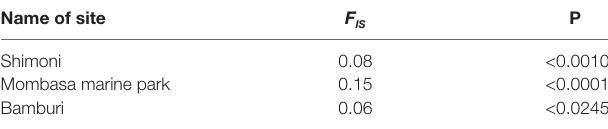
TABLE 4 | Table of specific F IS indices in each site revealing significant levels of inbreeding of Lethrinus mahsena population collected from Mombasa Marine Park, Bamburi, and Shimoni, coastal Kenya, as revealed by DArT markers.